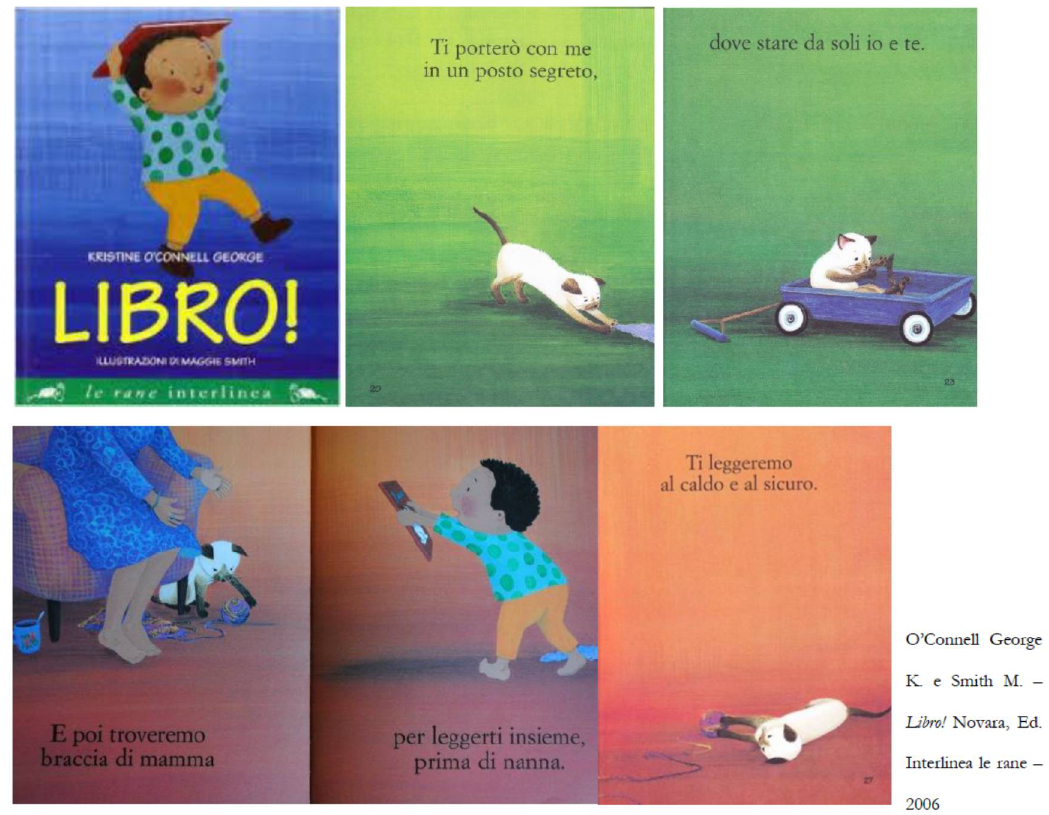
Figure A1. O’ Connell George, Smith M., Libro!, Novara, Interlinea,